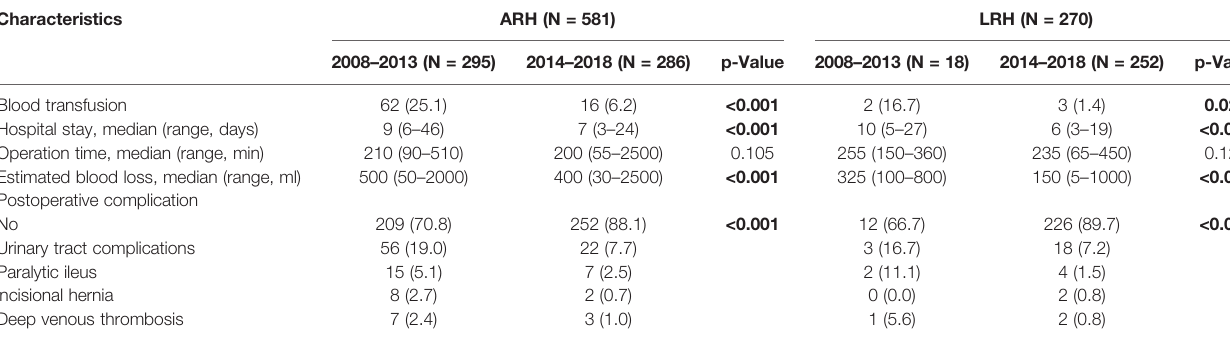
TABLE 2 | Perioperative outcomes in ARH and LRH groups.